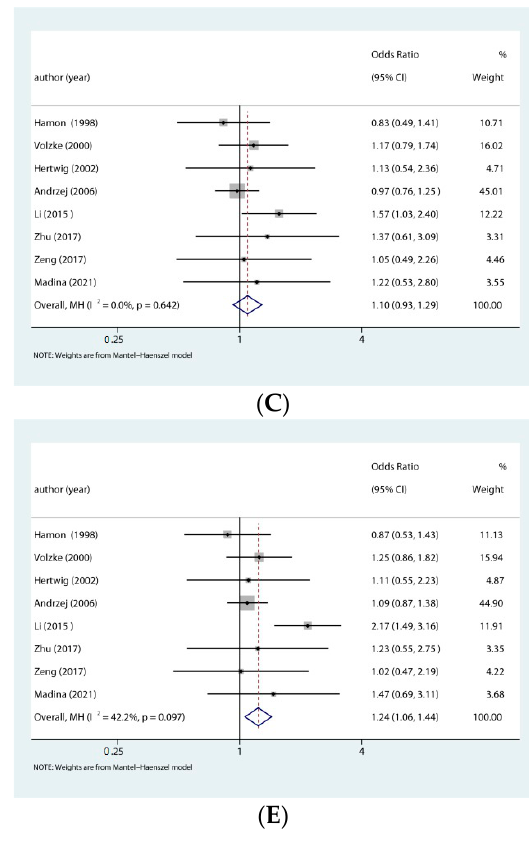
Table 4. Subgroup analyses of the association between AGTR1 rs5186 polymorphism and restenosis.